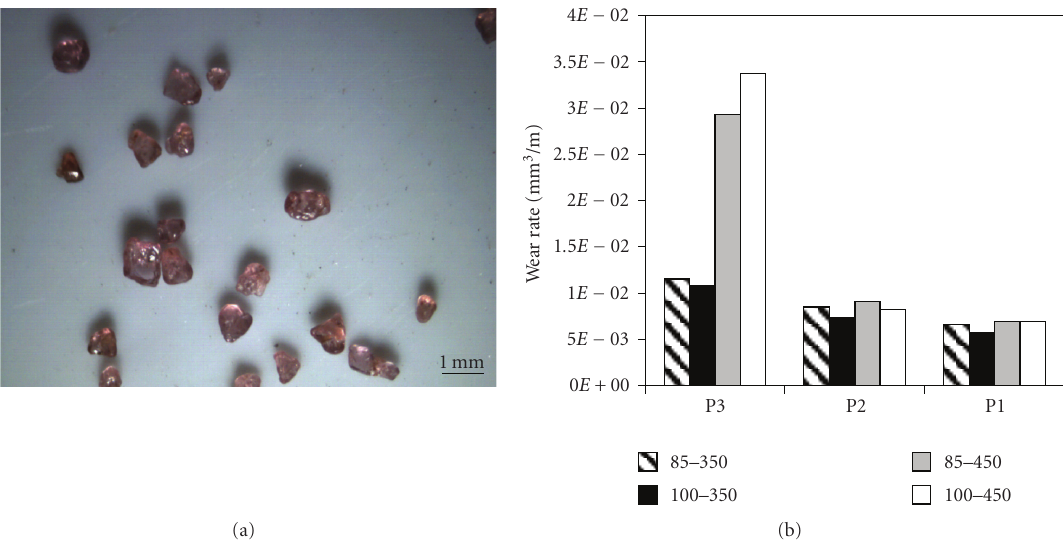
Figure 13: (a) Microimage of the garnet powder; light microscopy in reflected light. (b) SAR results of WC-17Co coatings in the garnet powder P3 compare to P2 and